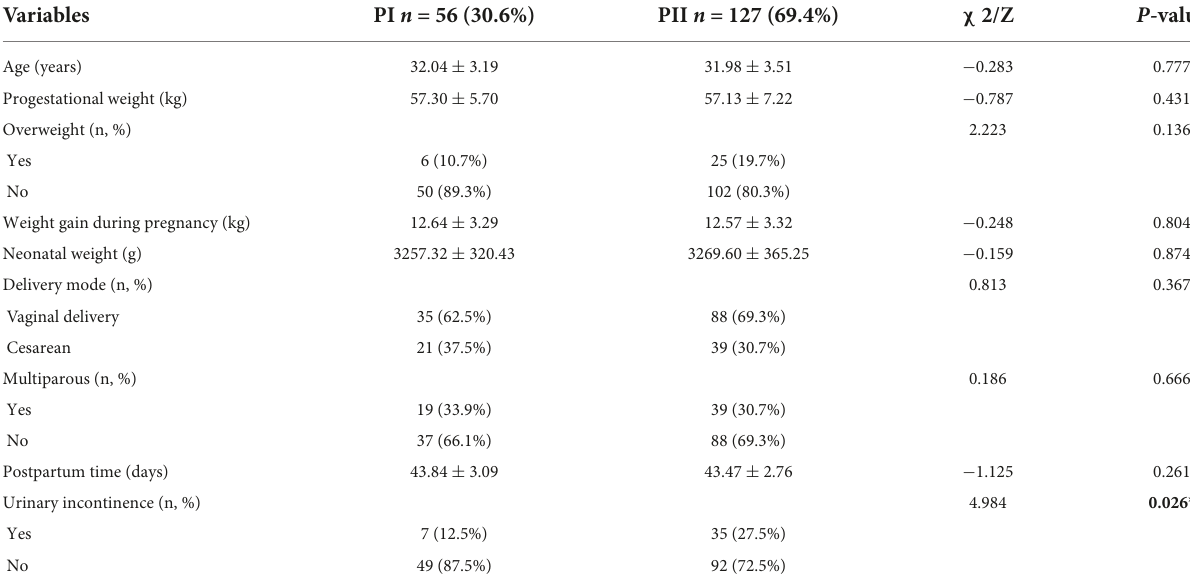
TABLE 1 Population characteristics of participants (total n = 183).